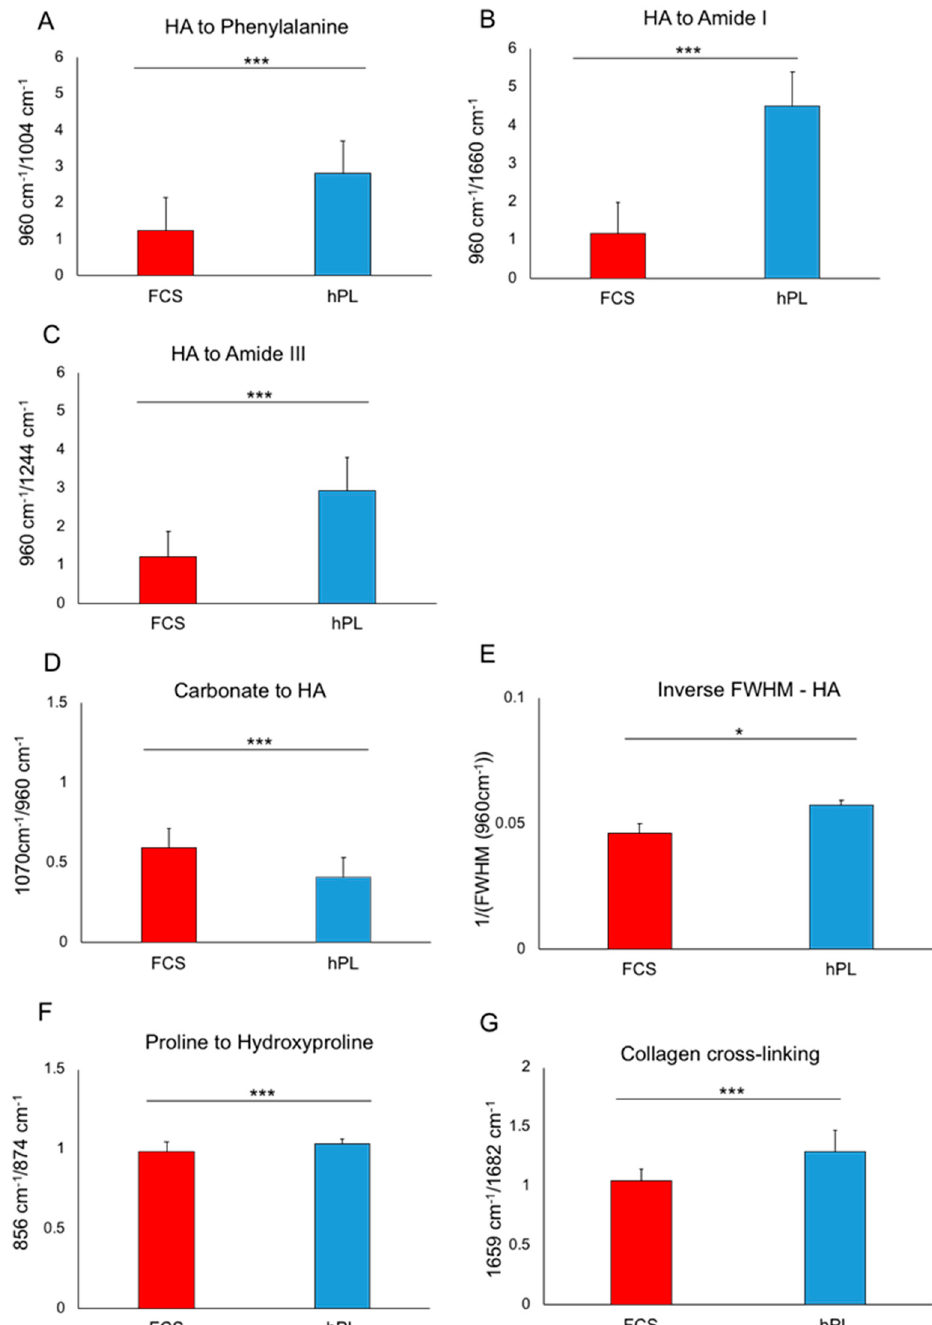
Figure 6. Ratios calculated from mean Raman spectra reflecting the biochemical composition of osteogenically-induced (OB) JPCs (four donors) under hPL and FCS supplementation. Phosphate to protein ratios ( A ) HA to phenylalanine; ( B ) HA to amid I; ( C ) HA to amid III; ( D ) carbonate content; ( E ) crystal size; ( F ) proline to hydroxyproline; ( G ) collagen cross-linking. Means (126–162 measurements per donor) ± standard deviations are depicted. * p < 0.05; *** p < 0.001. Abbreviations: FCS—fetal calf serum, hPL—human platelet lysate.